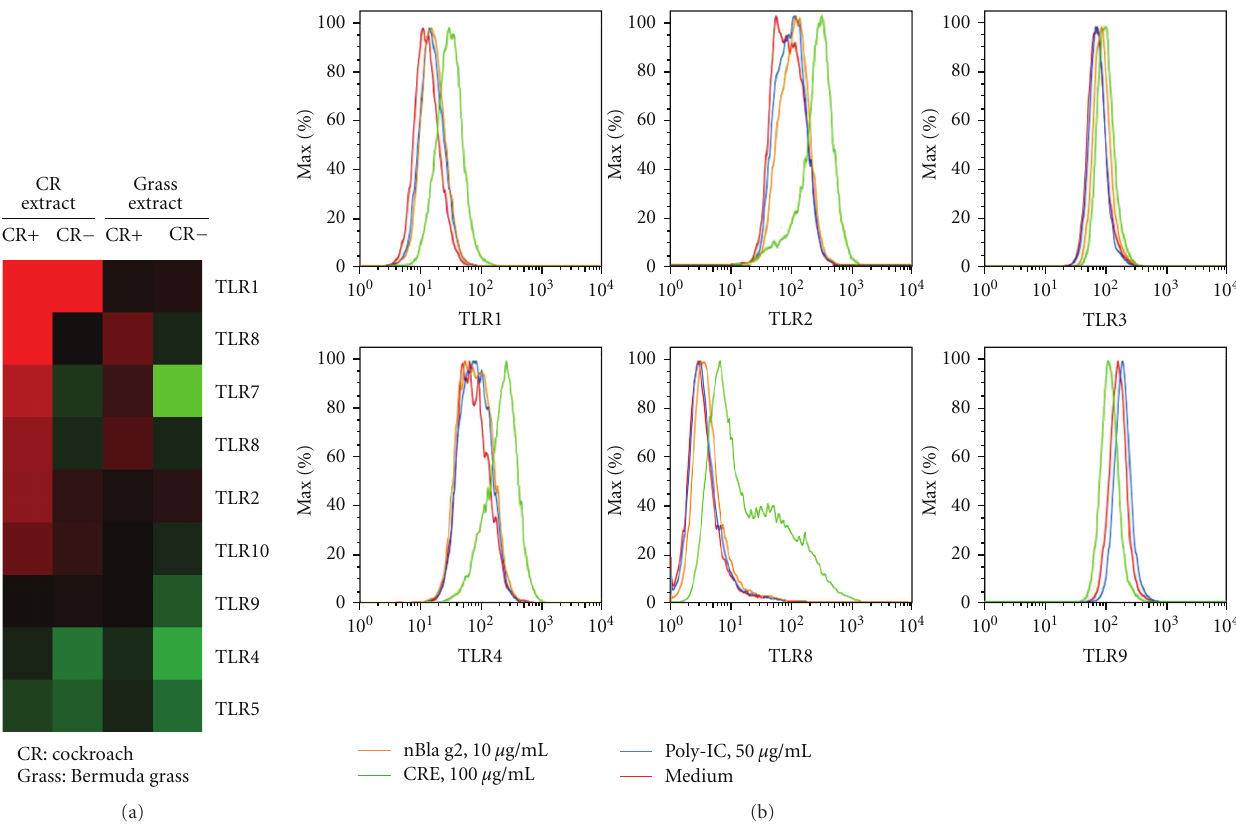
Figure 2: TLR gene expression in cocultured pDCs and CD4 + T cells and human THP-1 cells. (a) Microarray analysis of TLR transcripts expressed in cockroach allergen (CR) and Bermuda grass allergens treated cocultured pDCs and CD4 + T cells from cockroach-sensitized and -nonsensitized subjects. Upregulated genes are represented in red and downregulated genes in green. (b) TLR expression in THP-1 cells was detected at the protein levels by FACS (red, medium; orange: nBla g2; green: CRE, 100 ug/mL; blue: Poly-IC, 50